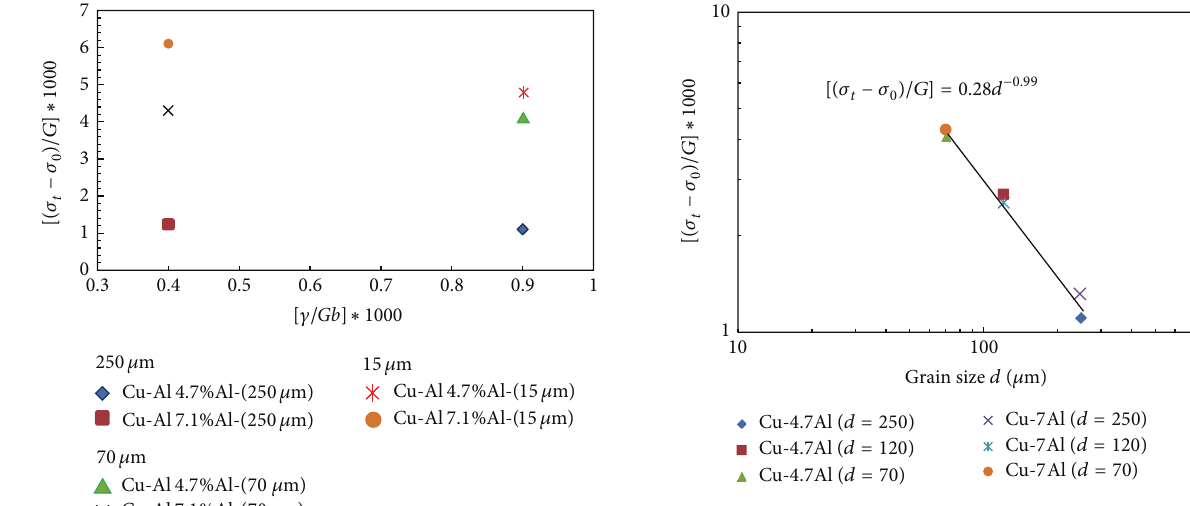
Figure 10: Normalized stress parameter [(𝜎 𝑡 − 𝜎 𝑜 )/𝐺] ∗ 1000 versus initial grain size for materials that displayed stage B and consequently twinning (Cu-4.7Al and